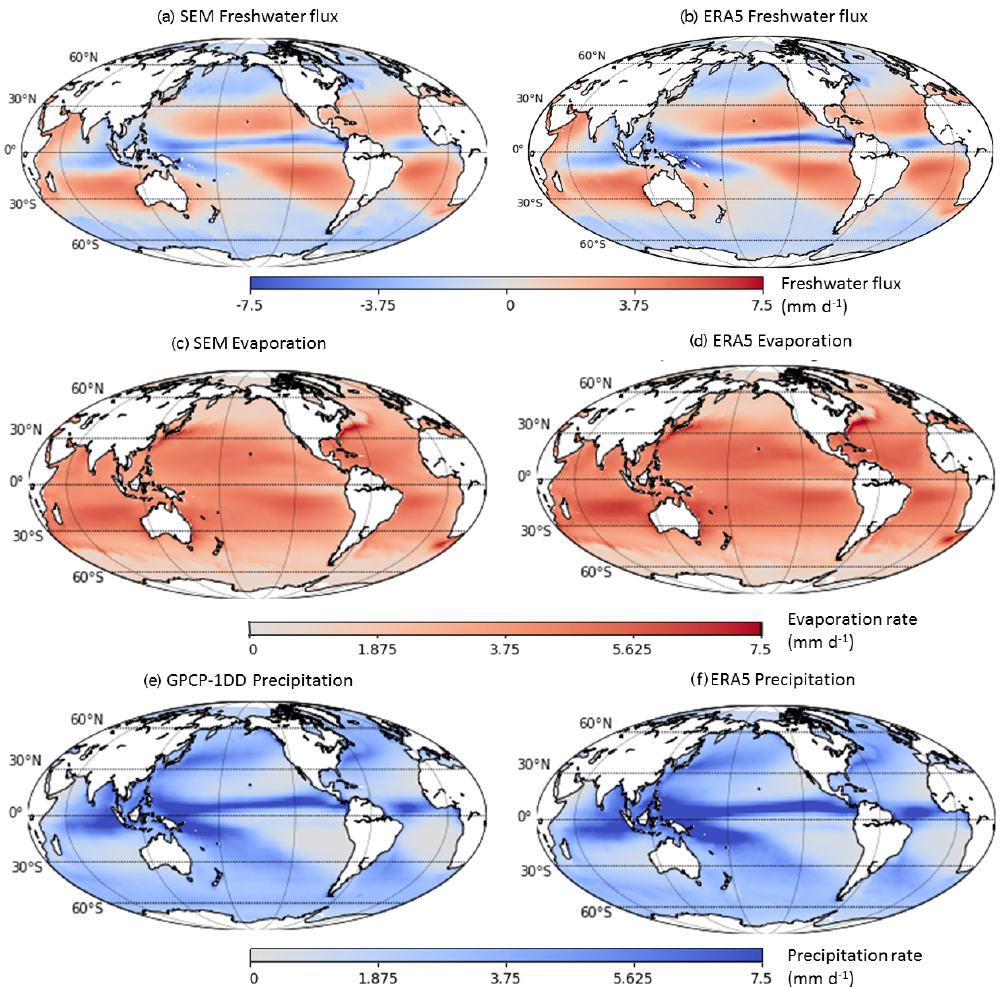
Figure 1. Satellite ensemble median (SEM) and ERA5 climatologies (1997–2013) of freshwater flux (a, b) and evaporation (c, d) , and GPCP and ERA5 precipitation (e, f) . ERA5 data coverage was reduced to match satellite data, and data over land were discarded from panels (e) and (f) . See the text for details.